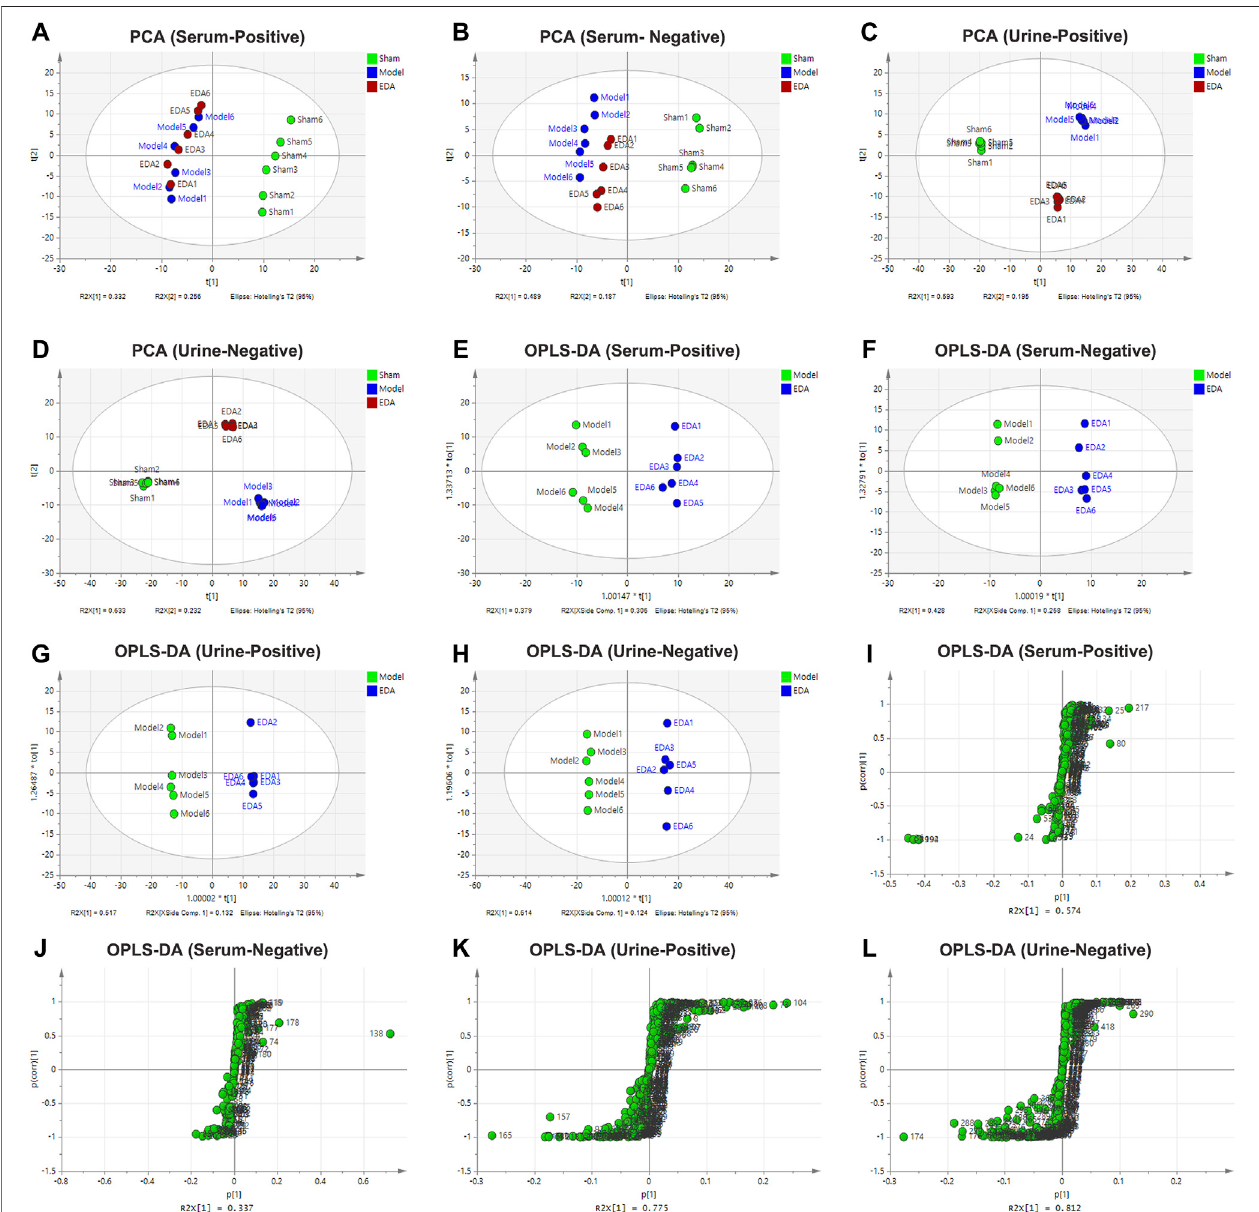
FIGURE 2 | PCA, OPLS-DA score plot, and S-plot of sham, model, and EDA group based on HPLC-Q-TOF/MS system for serum and urine analysis. (A – D) PCA score plot of model and EDA group. (E – H) OPLS-DA score plot of model and EDA group. (I – L) S-plot of model and EDA group.